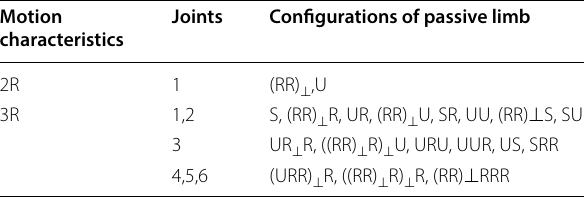
Table 2 Configuration synthesis of the passive limb Motion Joints Configurations of passive limb characteristics